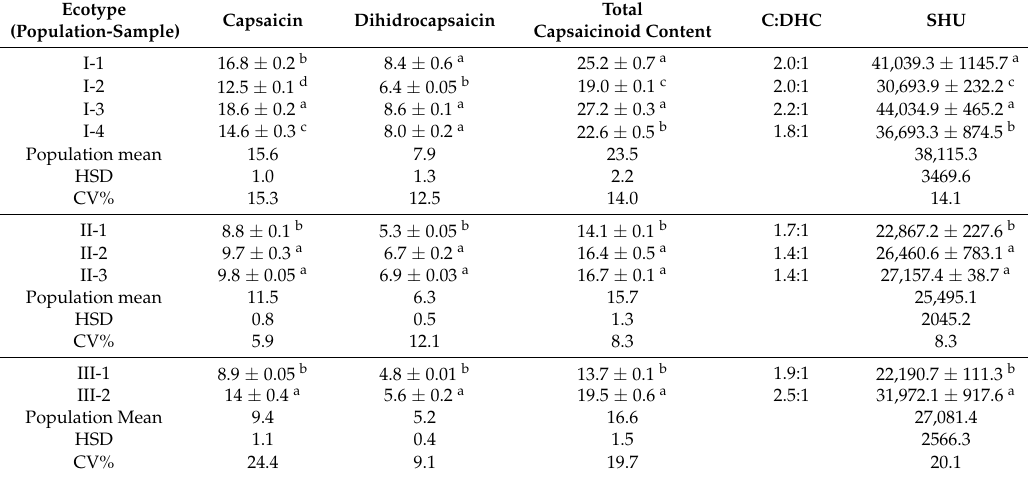
Table 3. Capsaicinoid content in wild populations of Piquin